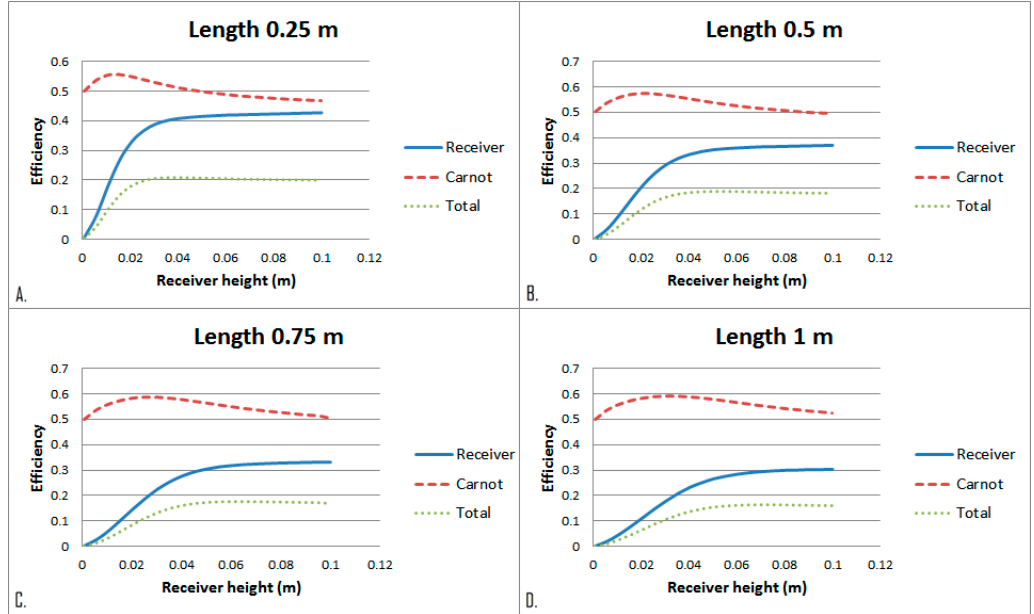
Figure 11. ( A ) Receiver height comparison at length of 0.25 m. ( B ) Receiver height comparison at length 0.5 m. ( C ) Receiver height comparison at length 0.75 m. ( D ) Receiver height comparison at length 1 m.